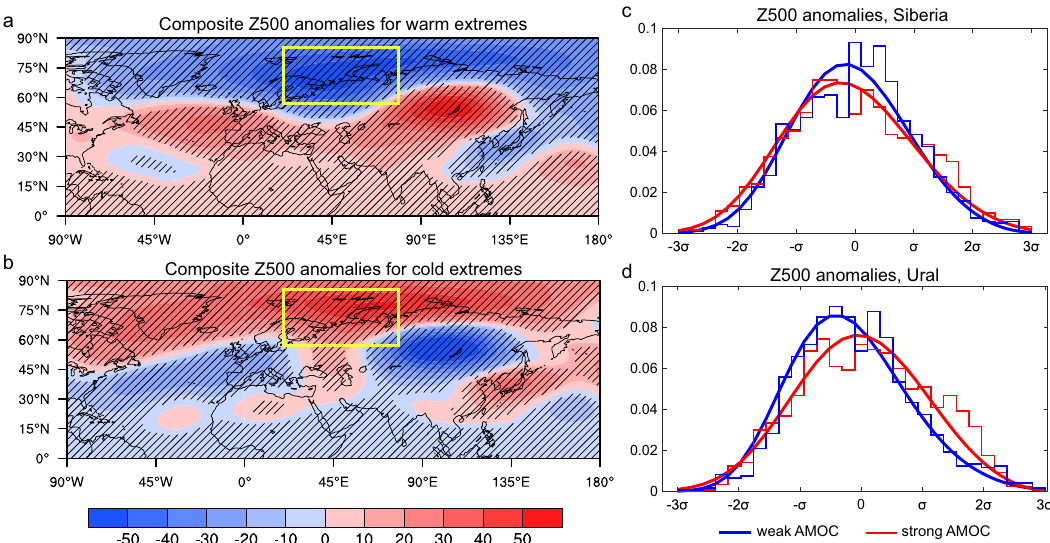
Fig. 5 A possible mechanism of the AMOC effect on atmospheric circulations. Composition of the daily Z500 anomalies (units: gpm) when warm ( a ) and cold ( b ) extremes occur over Siberia. Hatched areas indicate signi fi cance at the 95% con fi dence level using Student ’ s t test. The yellow boxes in a and b are the Ural blocking region. Frequency histograms (staircase curves) and GEV fi ttings (smooth curves) of the Z500 anomalies over Siberia ( c ) and the Ural blocking region ( d ) during the weak AMOC phase (blue lines) and strong AMOC phase (red lines). The x-axes in c and d are the standard deviations ( σ , units: K) of the daily Z500 anomalies, and the y-axes are the frequency histograms. All Z500 values are based on the JRA55